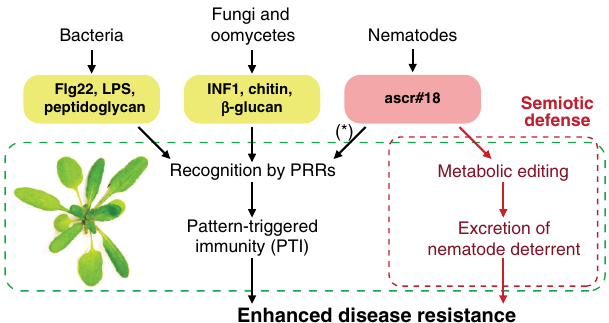
Fig. 6 Editing of ascr#18 and generation of repellent signals act in parallel with conventional innate immune responses in plants. Plants detect PAMPs such as fl g22, lipopolysaccharide (LPS), and peptidoglycan derived from bacteria, infestin 1 (INF1), chitin, and β -glucan derived from fungi/oomycete, and ascr#18 derived from nematodes via cell-surface- localized PRRs to induce conventional PTI. A parallel “ semiotic defense ” depends on metabolic editing of nematode-derived ascr#18 by the plant to generate a cocktail of ascarosides pheromones that acts as a repellent of parasitic nematodes (*PRRs